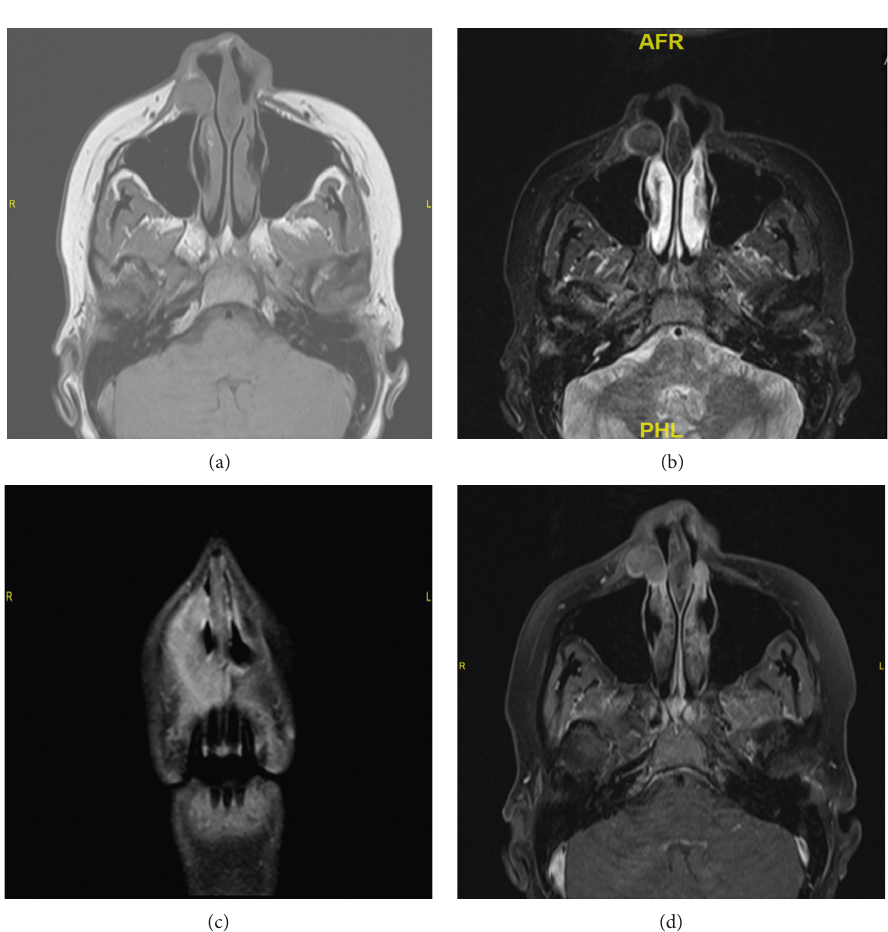
Figure 1: Magnetic resonance imaging. (a) Axial section shows well-defined subcutaneous soft tissue density located in the right nasolabial fold appearing isointensely on T1. (b) Hypointensity on T2. (c, d) Homogeneous enhancement after